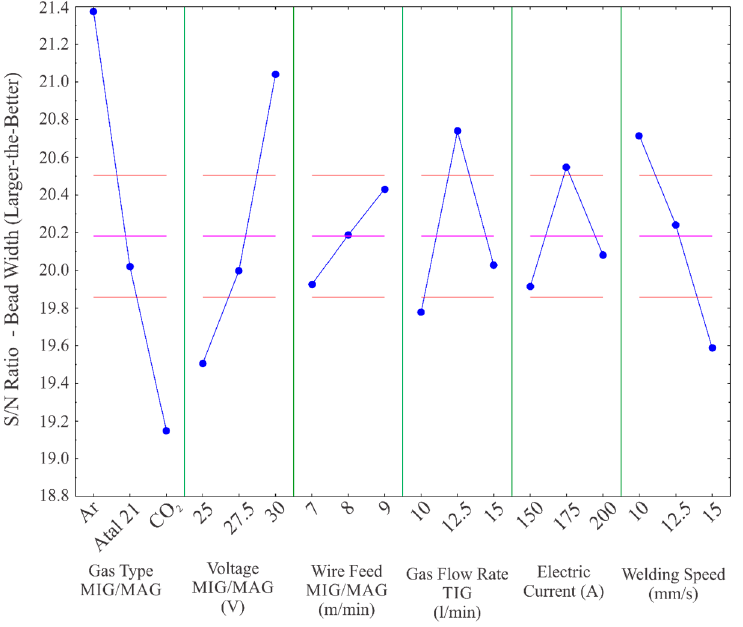
Figure 10. S/N ratio for obtaining the largest weld bead width.